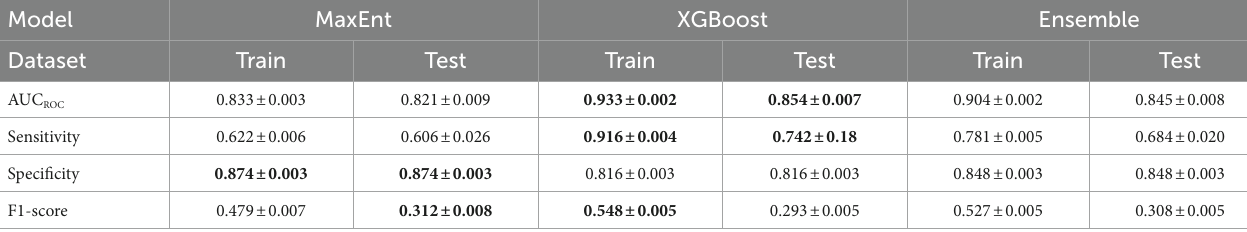
TABLE 2 Performance comparison across MaxEnt, XGBoost, and ensemble models.